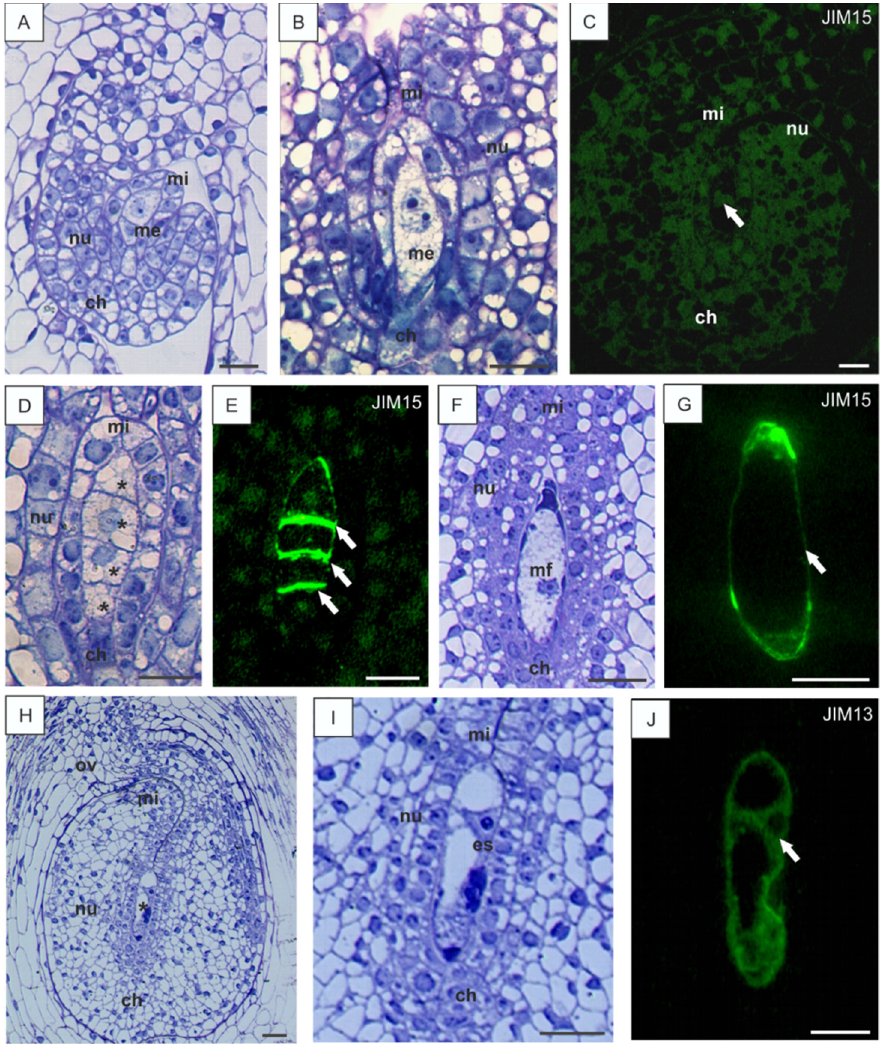
Figure 1. Histology of B. perennis ovules and immunolocalization of arabinogalactan proteins (AGPs) epitopes during megasporogenesis. Beginning of the differentiation process of the B. perennis ovule ( A ). Megasporocyte stage ( B ). Early stage of ovule development without visible presence of AGPs; reaction with JIM13; the arrow indicates megasporocyte ( C ). Tetrad of megaspores (asterisks) ( D ). AGP distribution in transverse walls between megaspores (arrows); reaction with JIM15 ( E ). Ovule with a functional megaspore ( F ). AGPs in the cell wall of the functional megaspore (arrow); reaction with JIM15 ( G ). Ovary with an ovule at the embryo sac stage ( H ). Magnification of a forming embryo sac ( I ). AGPs in the cell wall and cytoplasm of the embryo sac (arrow); reaction with JIM13 ( J ). Toluidine blue staining: ( A , B , D , F , H , I ). Immunolabeling: ( C , E , G , J ). Bars: 10 μ m ( A –